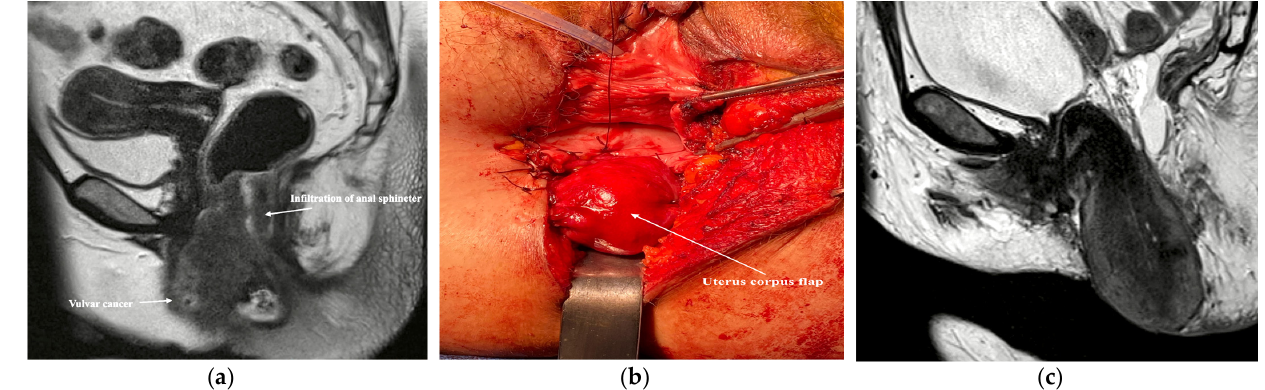
Figure 1. Pelvic reconstruction following a posterior exenteration with resection of Anus, posterior vaginal wall and vulva using the corpus uteri as a muscular flap: ( a ) the vulvar tumor with infiltration of anal sphincter; ( b ) intraoperative photo of adapting the corpus uteri flap to the defect edges after the demolitive surgery; ( c ) Magnetic resonance imaging of the corpus uteri flap two weeks after surgery.